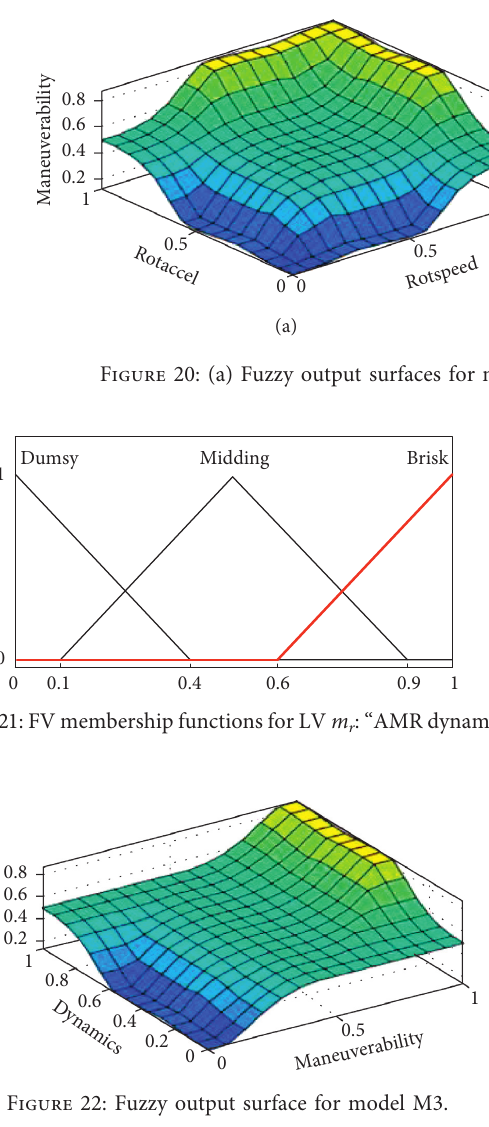
r : “angular acceleration”.